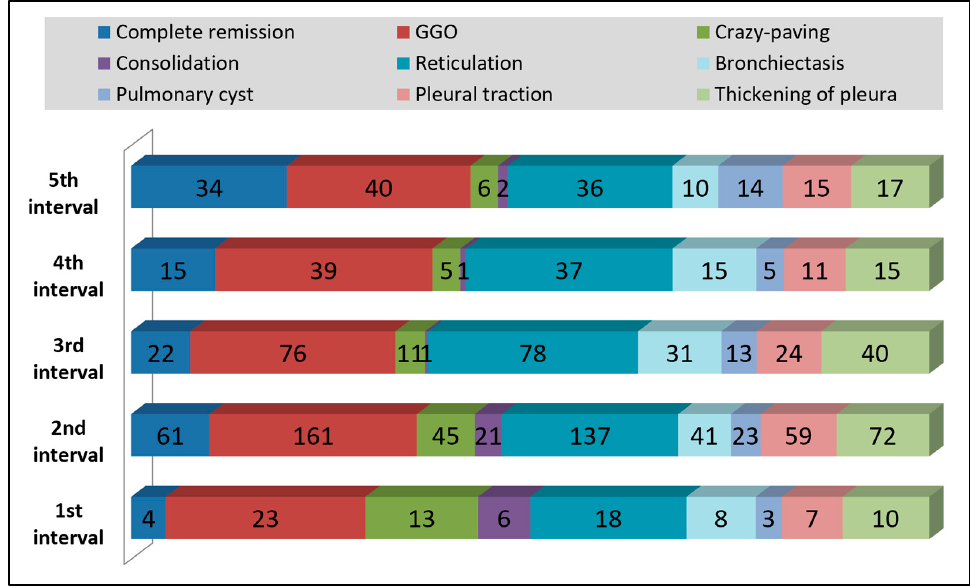
6 of 11 Table 2. Distribution of patients based on time intervals elapsed from the first positive COVID-19 test.